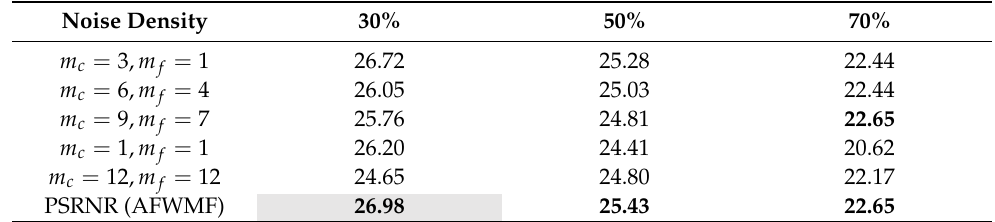
Table 16. The PSNR value for setting parameters by referring to the PSRNR formula (Plane image). Noise